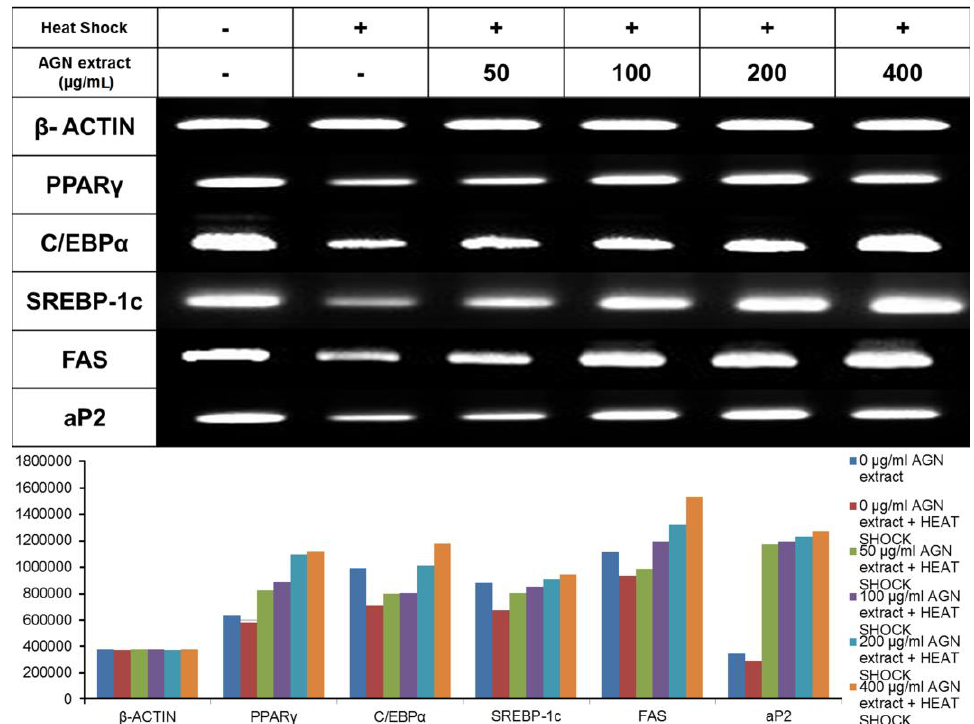
Figure 5. mRNA expressions with densitometry measurements of adipogenic markers in the differentiated murine 3T3-L1 after heat shock procedure at G0 stage, recovery and then treatment with Angelica gigas Nakai root hot water extract (0, 50, 100, 200, and 400 μg/mL) prior to differentiation